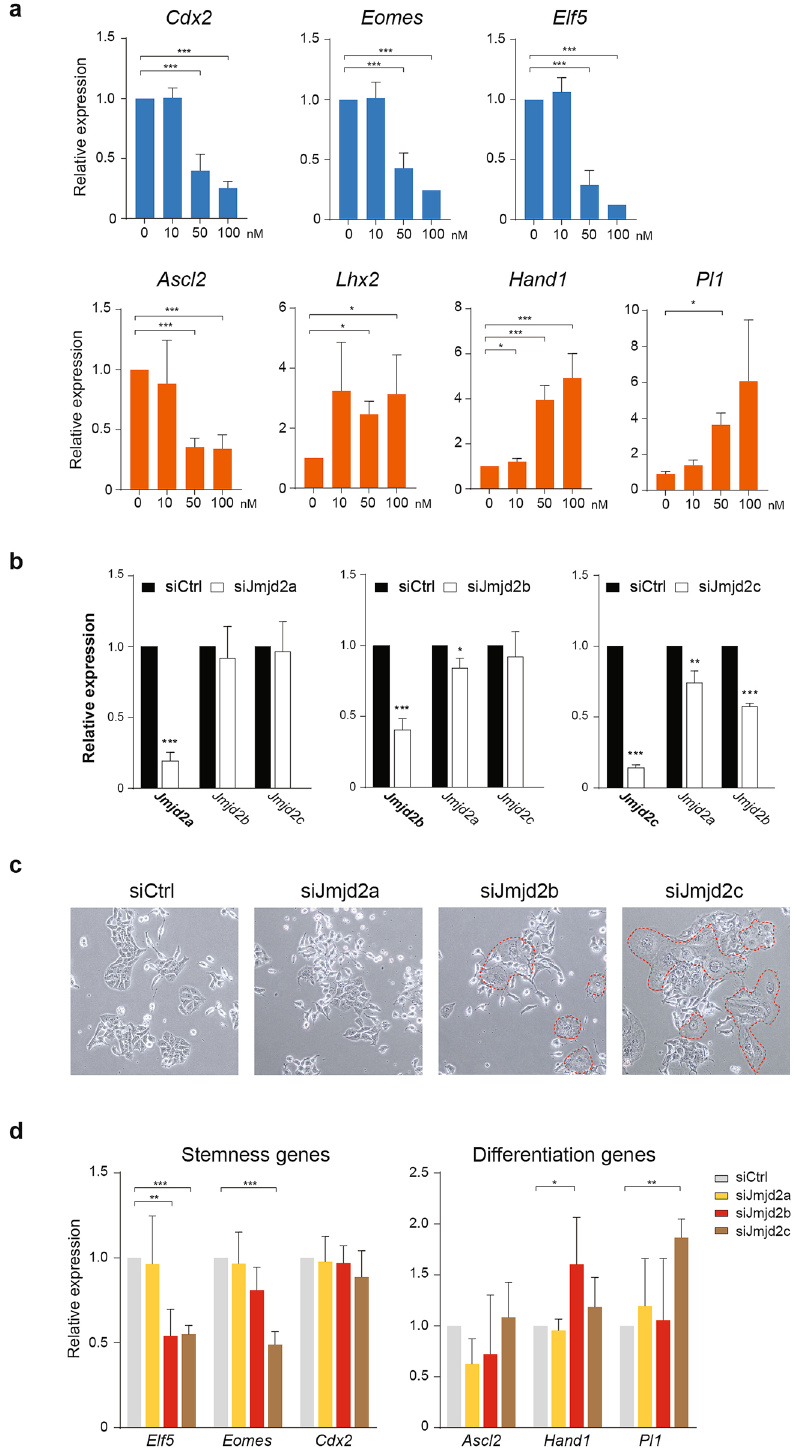
Figure 1. Inhibition of JMJD2 proteins induces TSC differentiation. ( a ) TSCs treated with pan-selective inhibitor of Jumonji histone demethylases JIB-04 exhibit downregulation of stem cell markers ( Cdx2 , Eomes and Elf5 ) and early differentiation marker Ascl2 , and upregulation of differentiation markers ( Lhx2 , Hand1 and Pl1 ). ( b ) Jmjd2a , Jmjd2b , or Jmjd2c was knockdown in TSCs by siRNA. Reduced gene expression at the mRNA level was confirmed by qRT-PCR analysis. ( c ) Cytoplasmic and nuclear-enlarged giant cell-like cells (encircled) were observed in Jmjd2b - or Jmjd2c -knockdown TSCs. ( d ) Knockdown of Jmjd2b significantly downregulated stem cell gene Elf5 and upregulates differentiation gene Hand1 expression, while knockdown of Jmjd2c significantly downregulated both Elf5 and Eomes , and upregulate differentiation factor Pl1 expression. Three independent experiments were performed with biological replicates of each sample. Data represent mean ± SD; Student’s t-test * P < 0.05, ** P < 0.01, and *** P <